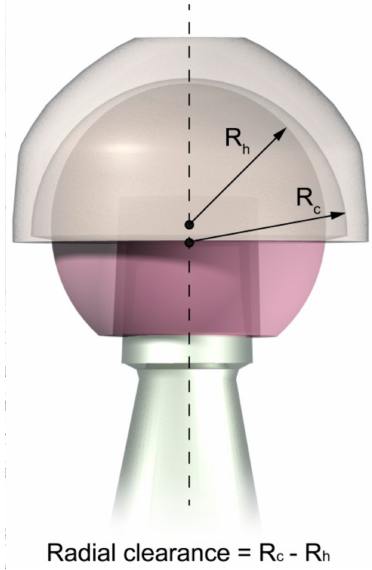
Figure 2. Radial clearance is the difference in radius of the acetabular cup and the femoral head. In this image the clearance is amplified for a better